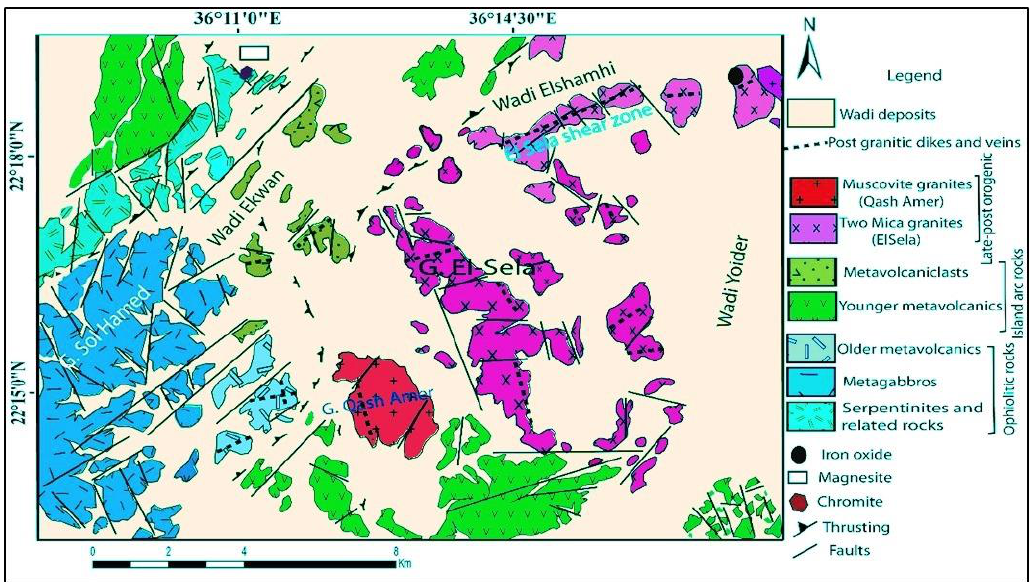
Figure 1. Geologic map of Sol Hamed area modified after [15].